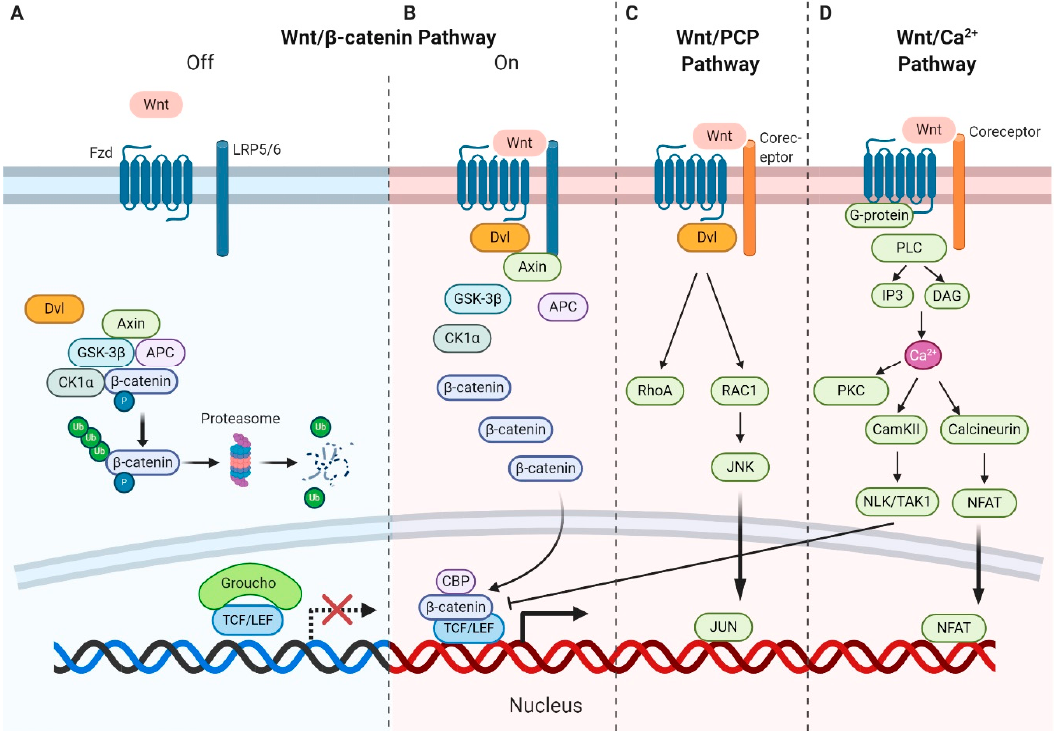
Figure 1. Wnt signaling pathways. Canonical Wnt– β -catenin pathway: ( A ) In the absence of Wnt (off state), the formation of the destruction complex, adenomatous polyposis coli (APC)–Axin–CK1 α – glycogen synthase kinase 3 β (GSK-3 β ) promotes β -catenin phosphorylation and degradation through the proteasome pathway. ( B ) In the presence of Wnt–Frizzled (Fzd) receptor interaction (on state) in association with the lipoprotein-receptor-related protein 5/6 (LRP5/6) coreceptor, the destruction complex is dissembled with promotion of β -catenin stabilization and nuclear translocation, triggering the expression of downstream Wnt target genes. Noncanonical Wnt pathways interact with Fzd and other coreceptors to recruit a disheveled segment polarity protein (Dvl). ( C ) In the Wnt–planar cell polarity (PCP) pathway, Dvl activates the small GTPases RhoA and RAC1, resulting in activating c-Jun N- terminal kinase (JNK). ( D ) Sidewise in the Wnt–Ca 2+ pathway, activated phospholipase C (PLC) results in a cytosolic calcium flux, which, in turn, through several intermediate steps, promotes the nuclear factor of the activated T-cell (NFAT) transcription. ↓ = Activation; ⊥ = Inhibition.